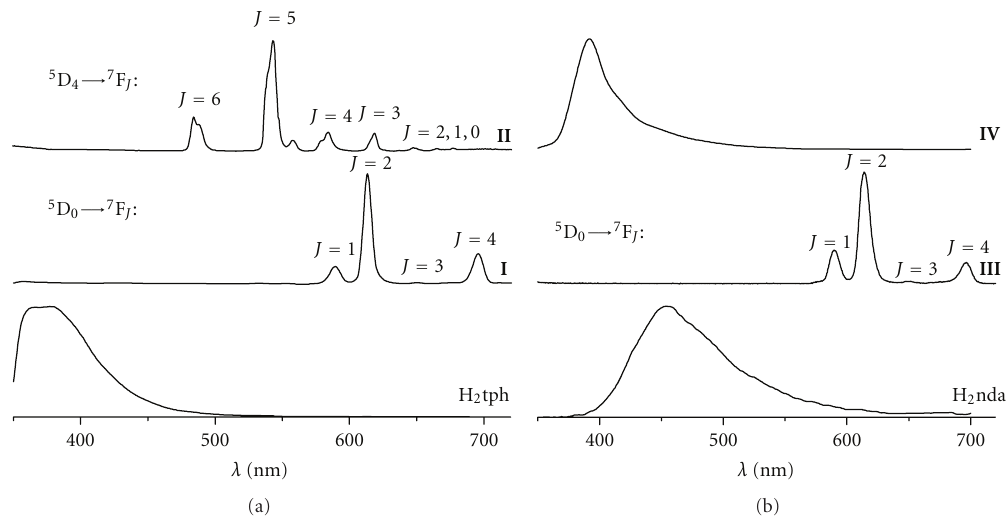
Figure 4: Normalized luminescence spectra of H 2 tph, Eu 2 (tph) 3 (H 2 O) 4 (I) , Tb 2 (tph) 3 (H 2 O) 4 (II) , H 2 nda, Eu 2 (nda) 3 (H 2 O) 6 (III) and Tb 2 (nda) 3 (H 2 O) 6 (IV) ( λ ex = 260 nm).